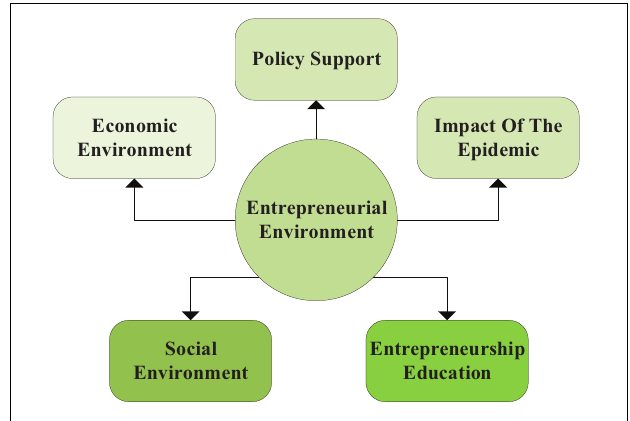
FIGURE 6 | Variable indicators of entrepreneurial environment.